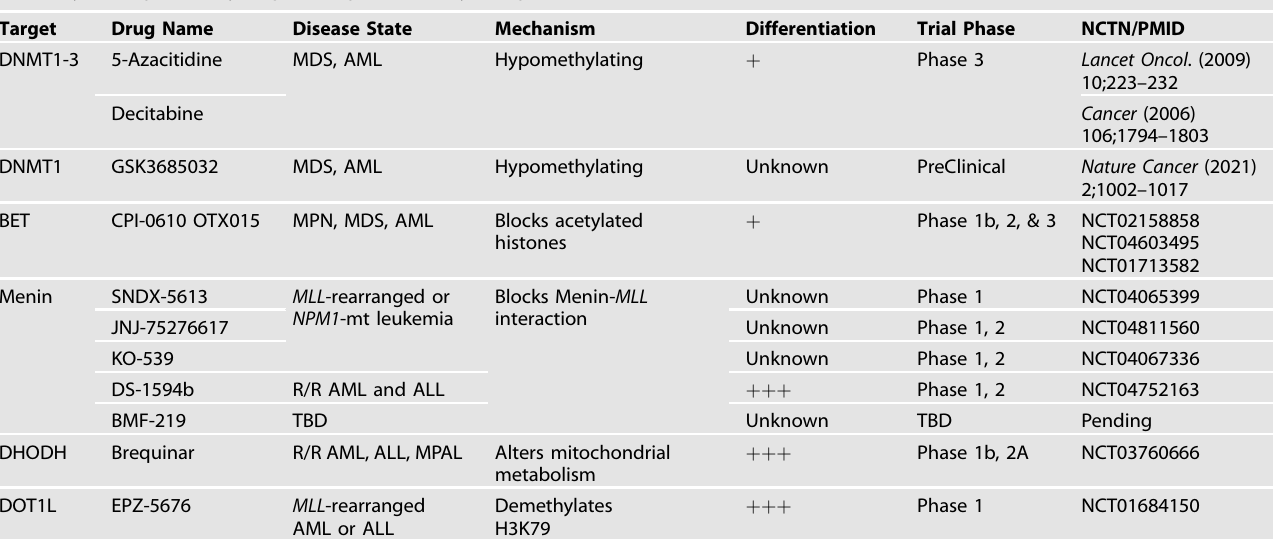
DNMT1 DNA methyltransferase 1, DOT1L like histone lysine methyltransferase 1, DHODH dihydroorotate dehydrogenase, BET bromodomain and extraterminal proteins, MDS myelodysplastic syndrome, MPN myeloproliferative neoplasm, AML acute myeloid leukemia, ALL acute lymphoblastic leukemia, MPAL mixed- phenotype acute leukemia